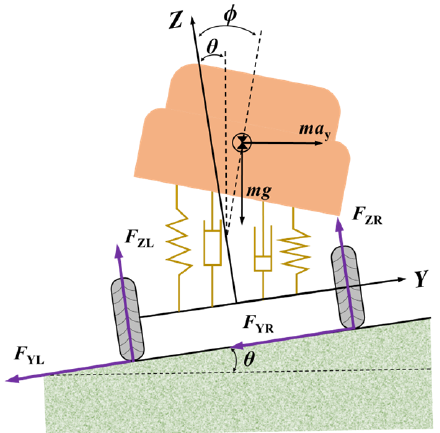
Figure 3. Front view of vehicle model on curve segments.